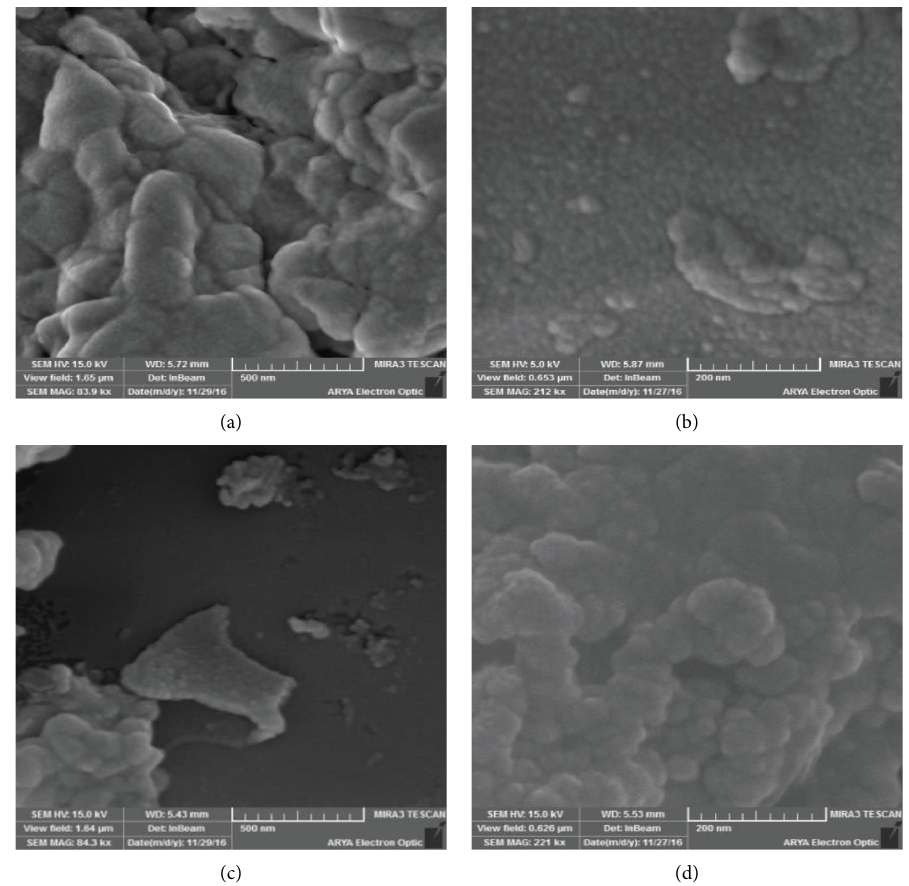
Figure 1: FESEM images tea treated pulp magnetite nanoparticles at temperatures of 400 (a and b) and 450 ° C (c and d) and diferent